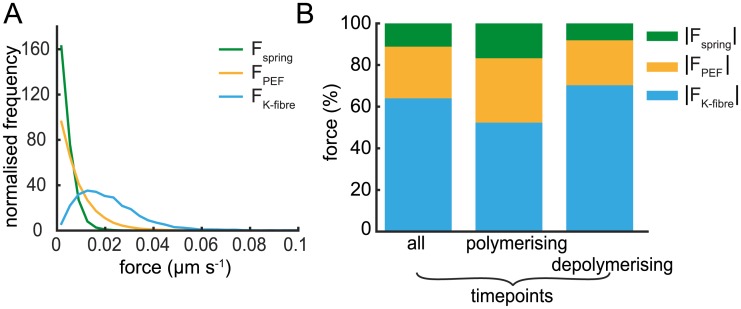
Average force decomposition across the population of trajectories.(A) Distributions of absolute forces (spring, PEF and K-fibre) averaged over trajectories (and sisters). (B) Mean force partition averaged over all time-points, time-points where the kinetochore is attached to a polymerising or depolymerising K-fibre. Absolute force values are averaged over respective sister and time-points across all trajectories (n = 843).